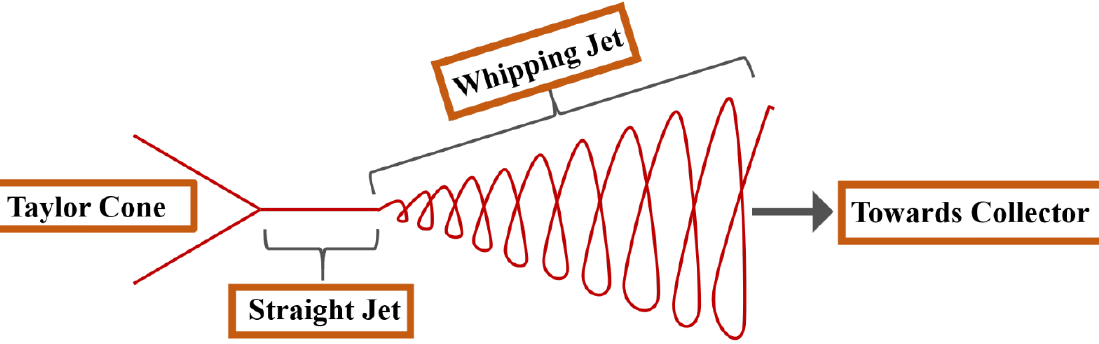
Figure 2. The different stages of electrospun jet leading to nanofiber formation [12] .